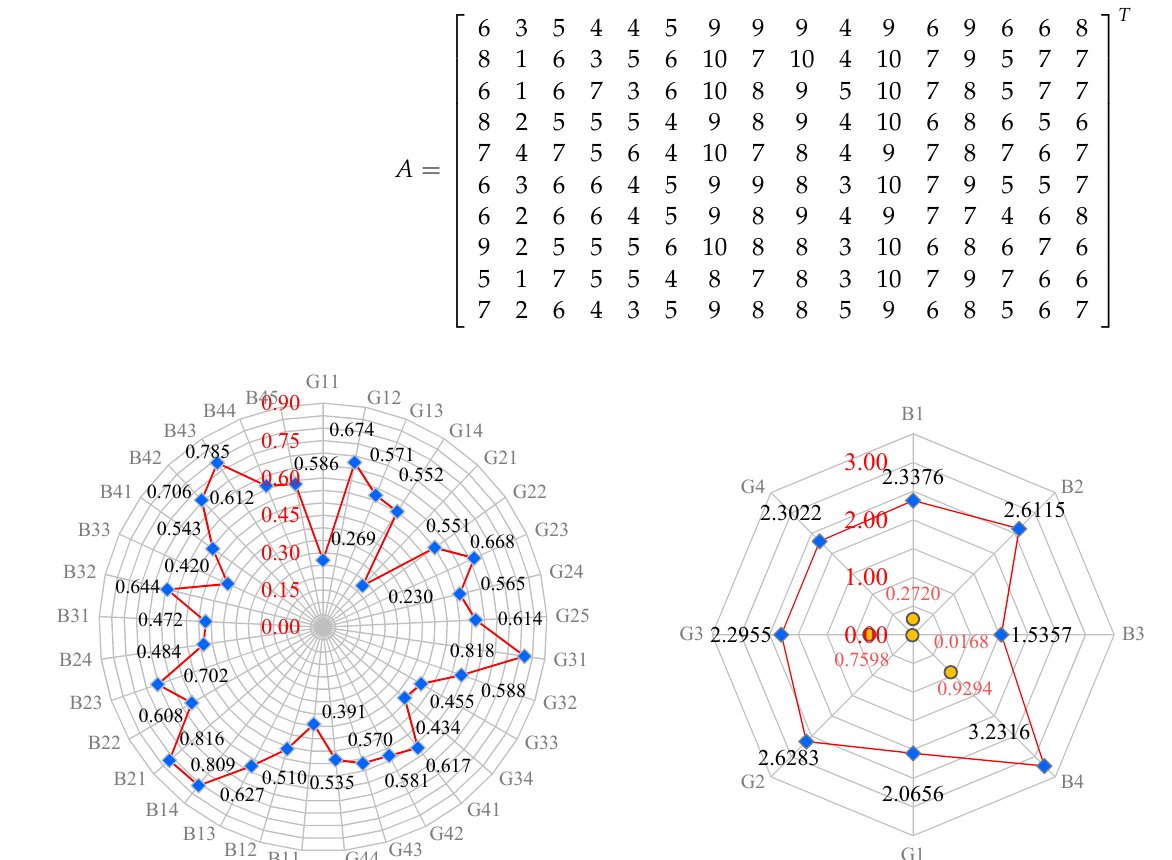
Figure 6. Scores of index layer and factor layer of immune system of chemical enterprise in G-B model.